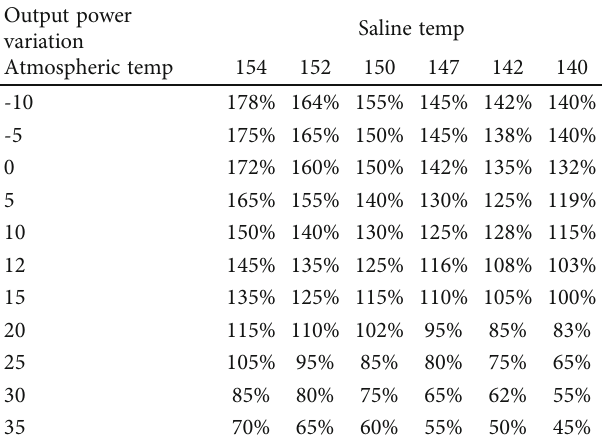
Table 5: Output power